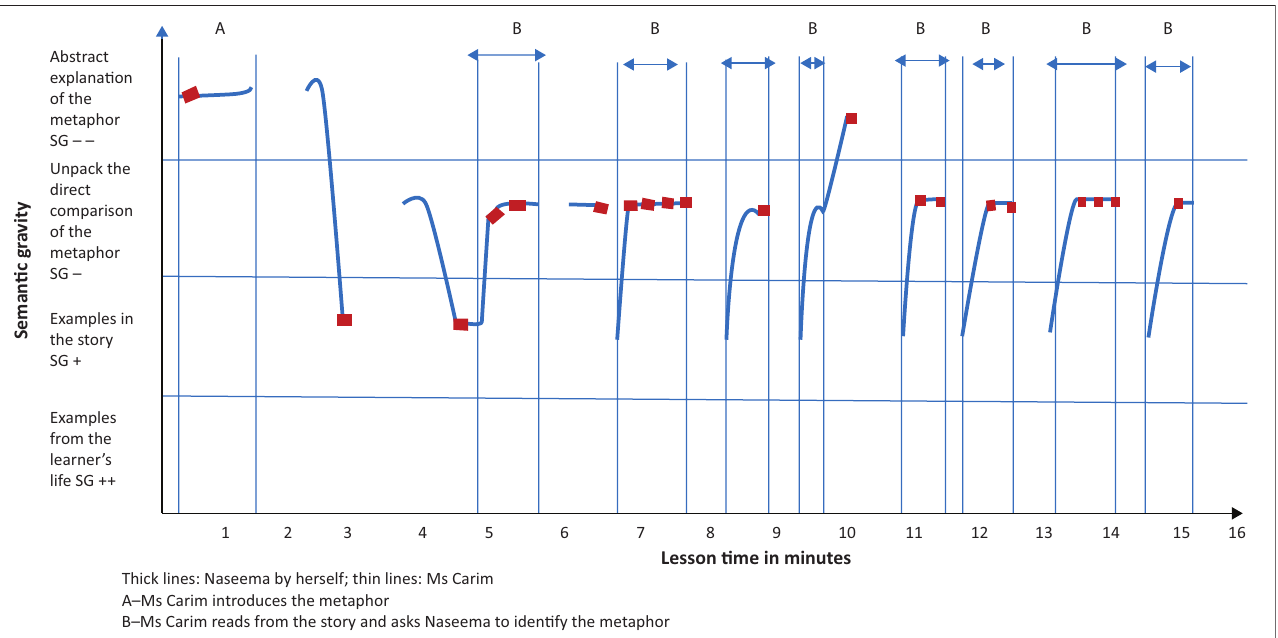
FIGURE 3: Semantic profile for Naseema’s